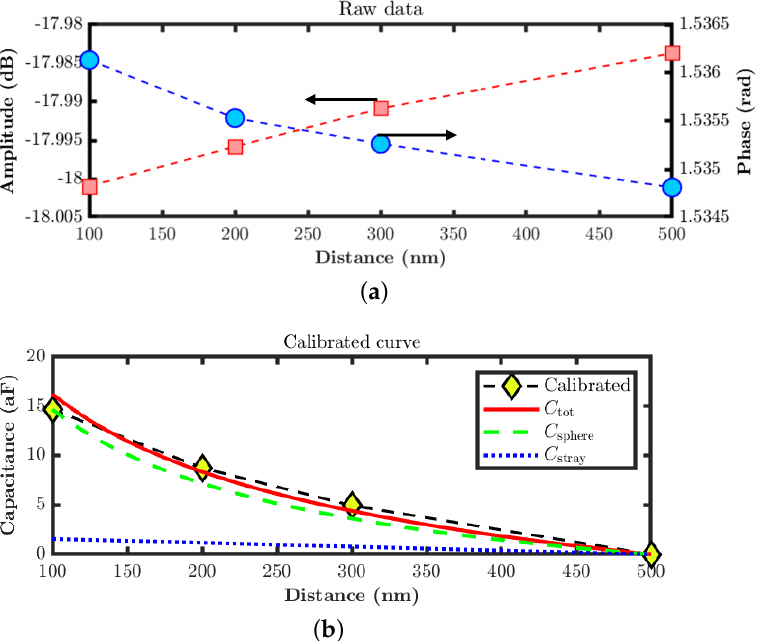
Figure 6. Approach curve calibration. ( a ) Raw data of the S 11 approach curve on top of the signal line, measured at a frequency of 5.99 GHz. ( b ) Calibrated capacitance curve compared with an analytical model of the tip as a